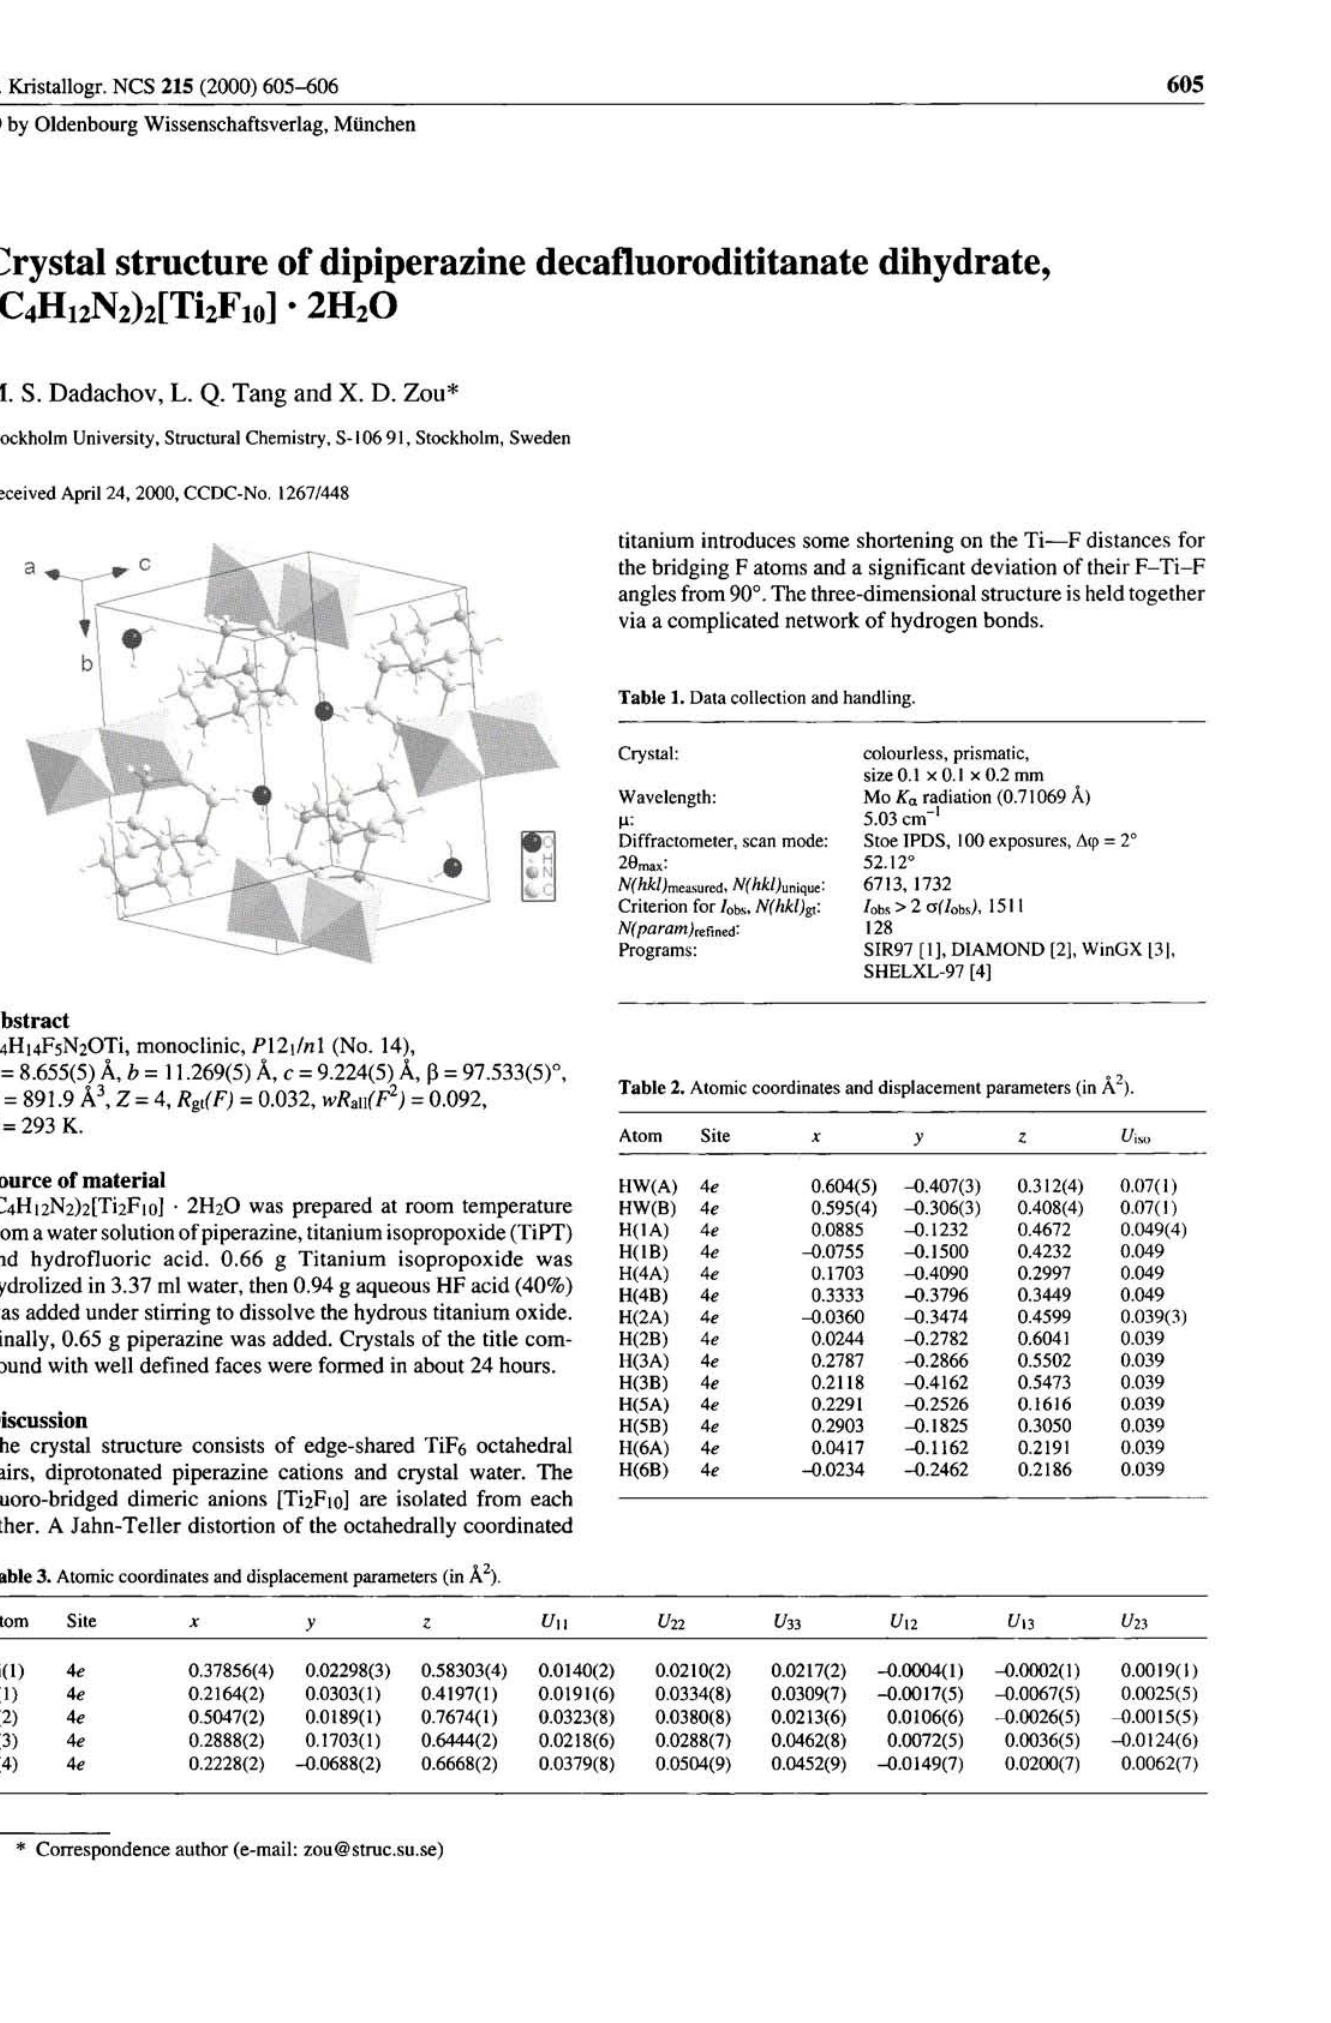
Table 2. Atomic coordinates and displacement parameters (in